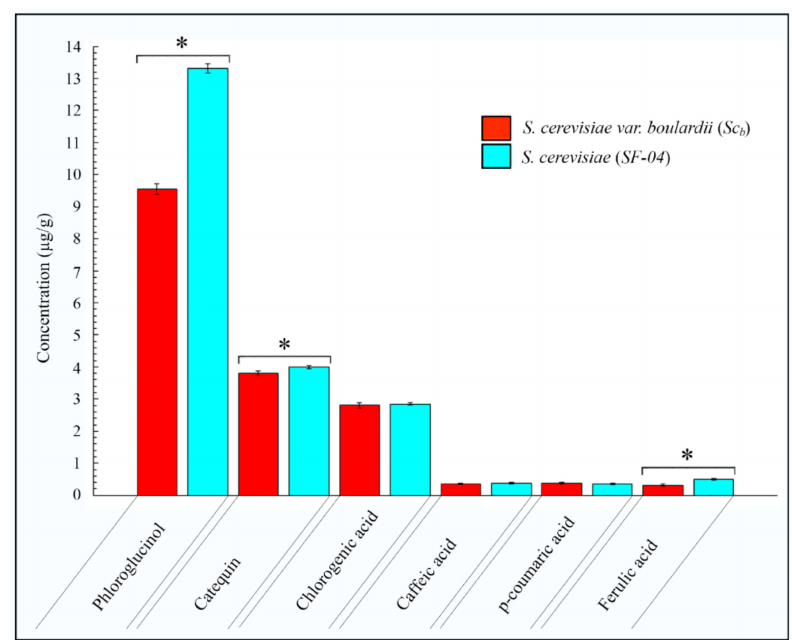
Figure 2. Hıgh performance lıquıd chromatograpy results for the beers fermented with the Saccharomyces cerevisiae var. boulardii ( S Cb ) and Saccharomyces cerevisiae (SF-04) yeast strains. The polyphenols were detected at three di ff erent wavelengths (270 nm, 324 nm and 373 nm). Results shown as mean ± standard deviation. * Statistically significant di ff erence of polyphenol concentrations ( p < 0.05).